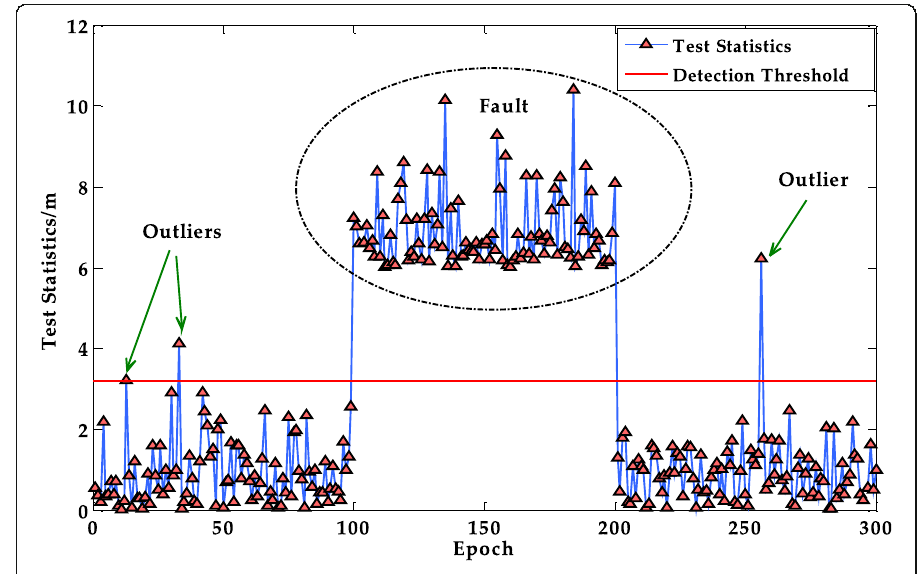
Fig. 4 A diagram of outliers and fault